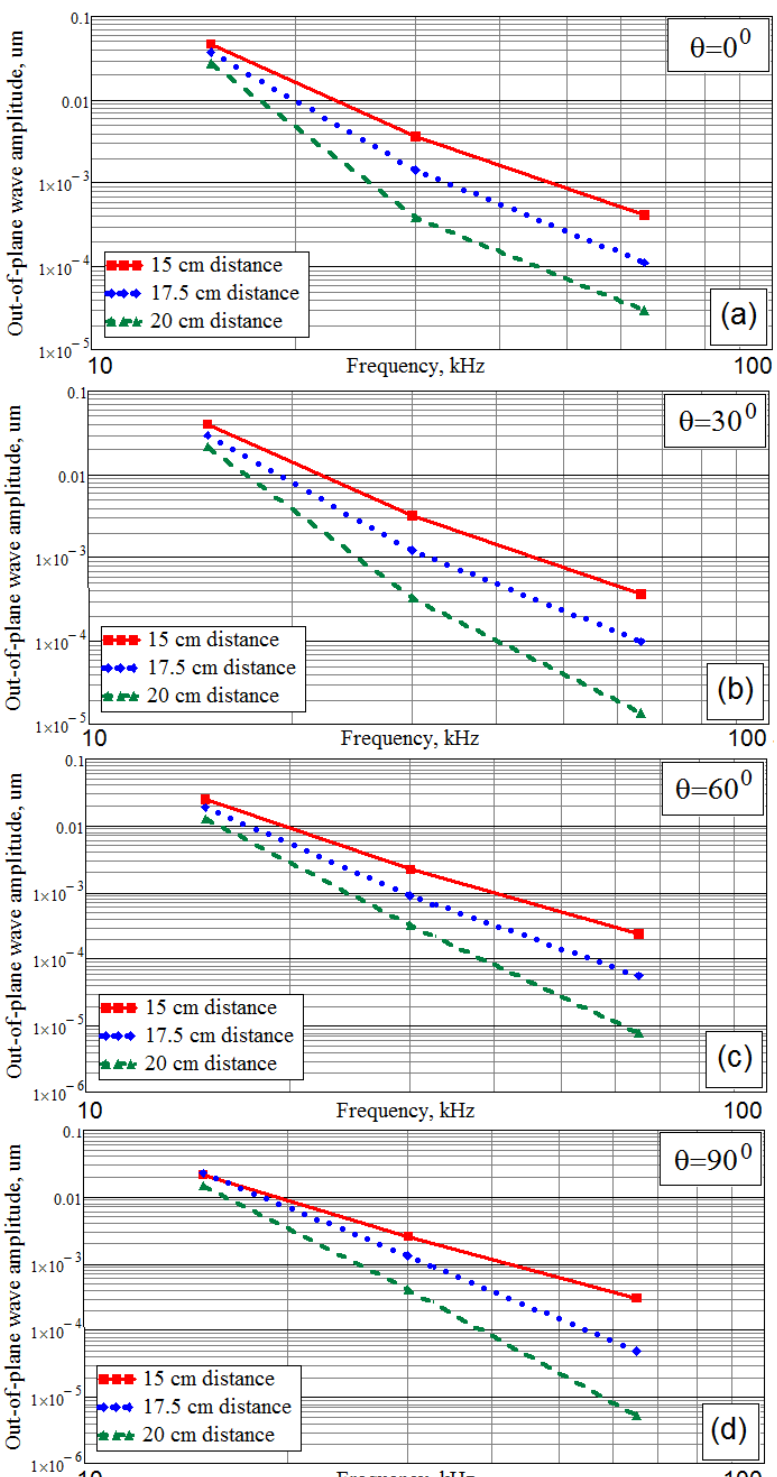
Figure 14. The attenuation of the A0 Lamb waves propagating along the main lobes of the directivity diagrams at the different wedge actuator orientation: along the main orthotropic axes of the material ( a ), and rotated 30, 60 and 90 degrees ( b , c , d , respectively) and the waves excitation frequencies.